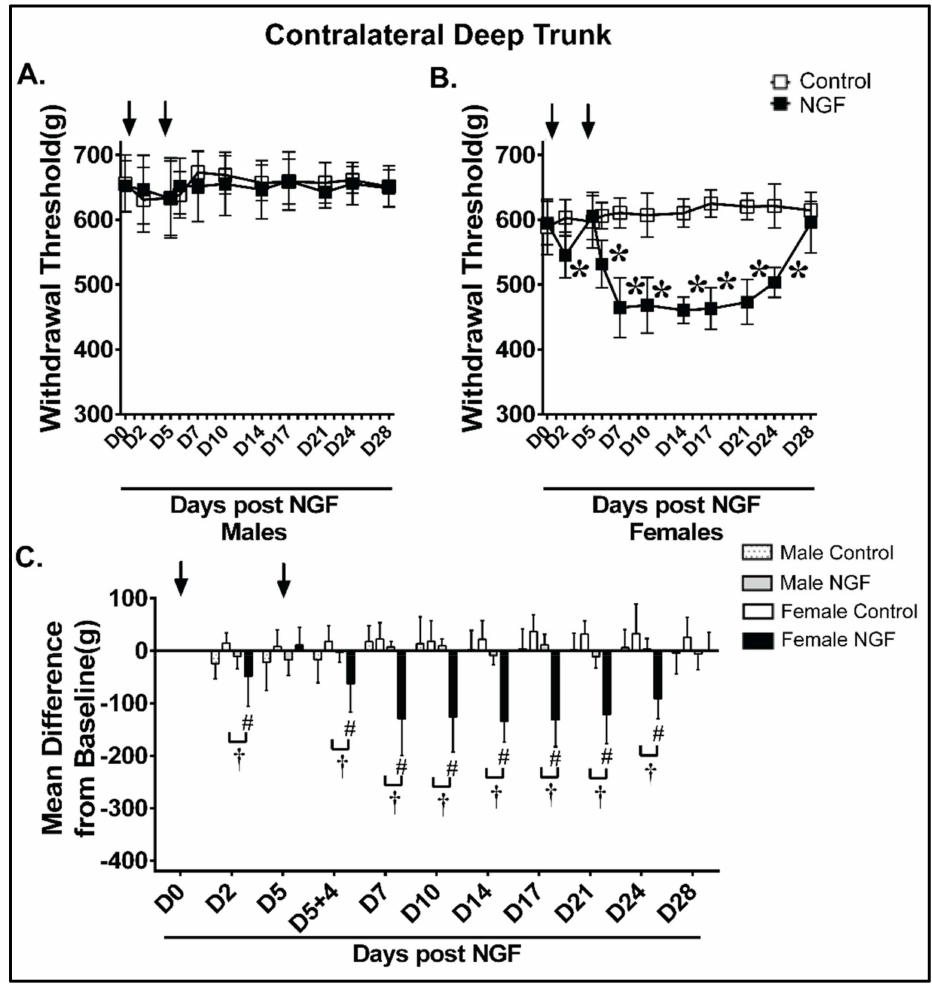
Figure 5. Females demonstrated contralateral low back mechanical hyperalgesia after NGF injections compared with males. When compared to control (PBS), NGF injections (arrows) resulted in con- tralateral low back mechanical hyperalgesia with algometer testing in ( B ) female but not ( A ) male rats. ( B ) Female NGF rats had significant decreased thresholds by D2 and then D5 + 4 h that persisted through D24 when compared to baseline (D0). ( C ) NGF induced significant changes in the mean difference from baseline thresholds in females when compared to time-matched vehicles and the male NGF group at D2 and then D5 + 4 h that persisted through D24. Contralateral LBP resolved by D28 in females. Data were analyzed by two − way ANOVA with ( A , B ) Bonferroni’s compar- isons within groups compared to D0 or ( C ) Tukey’s comparisons between groups for n = 8/group. * p < 0.01 vs. D0 prior to injection and # p < 0.01 vs. time − matched vehicle group, † p < 0.01 vs. NGF male